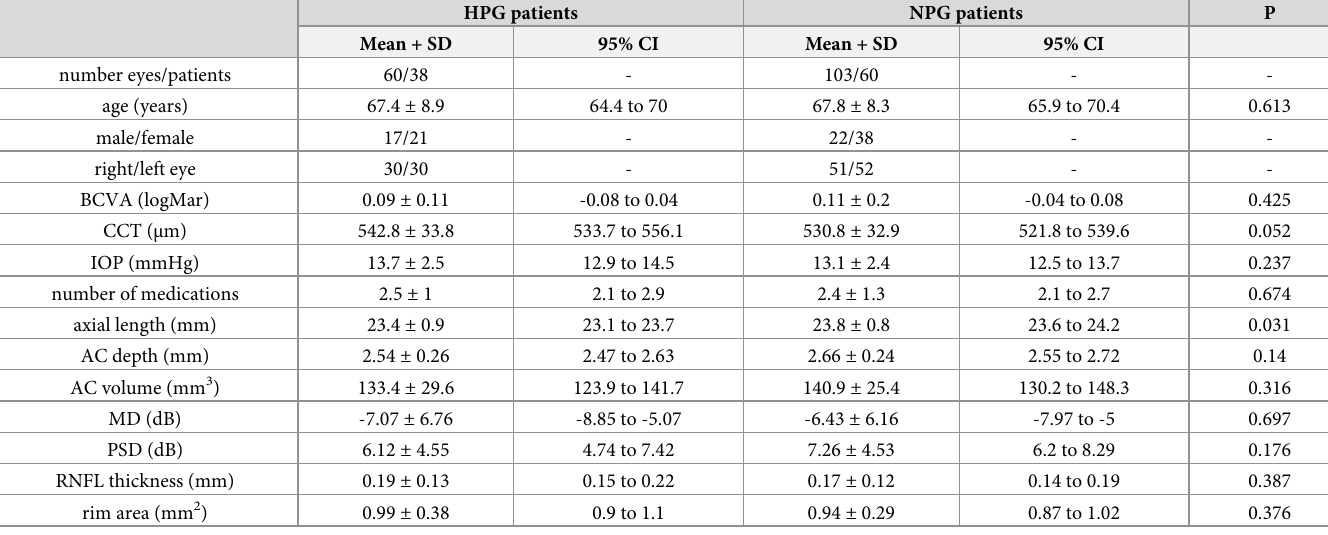
Table 1. Baseline data of high pressure (HPG) and normal pressure glaucoma (NPG) patients after group matching for intraocular pressure, central corneal thick- ness and age. HPG patients NPG